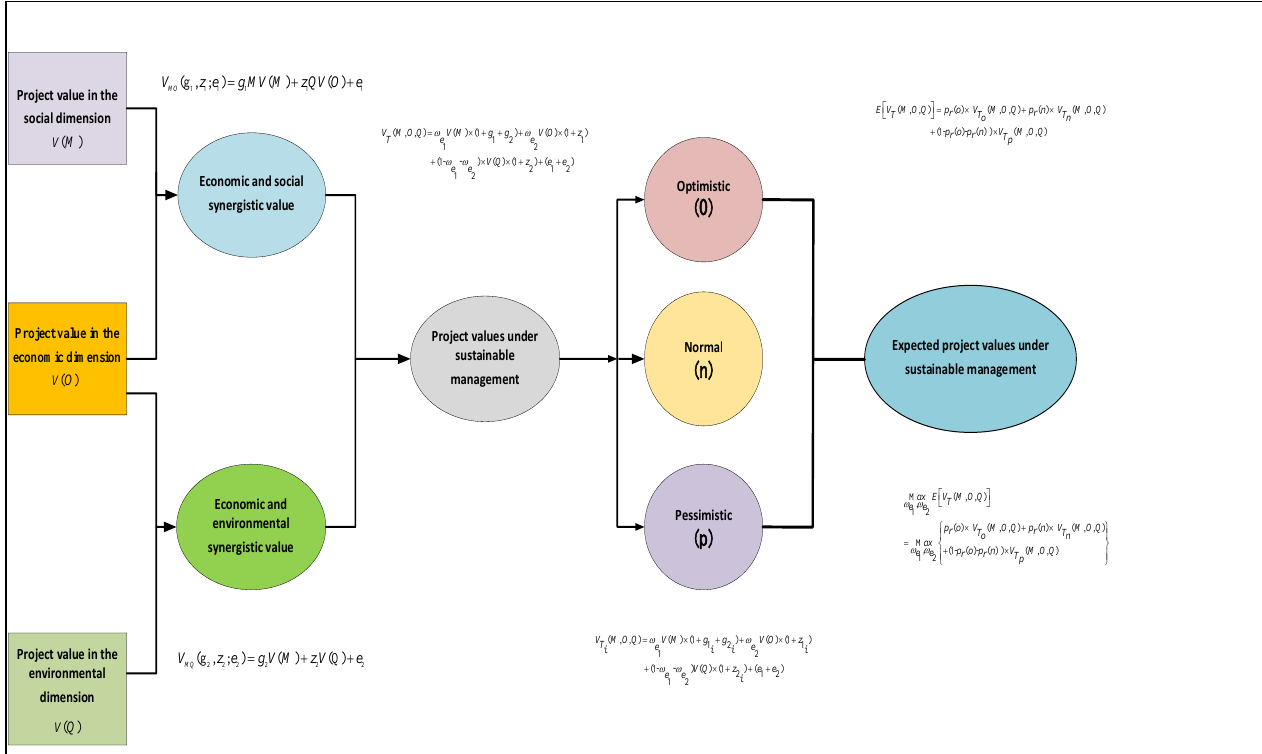
Figure 1. Optimal evaluation structure of synergy value and weight in sustainable management projects.